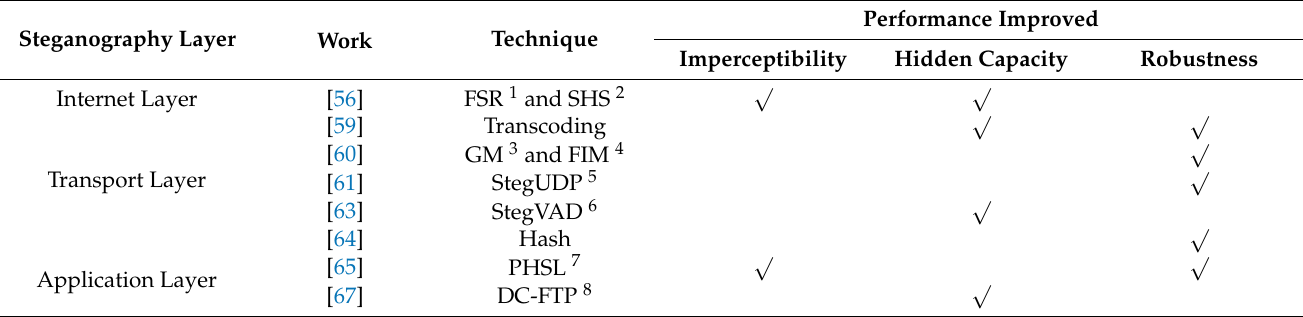
Table 7. Steganography methods based on